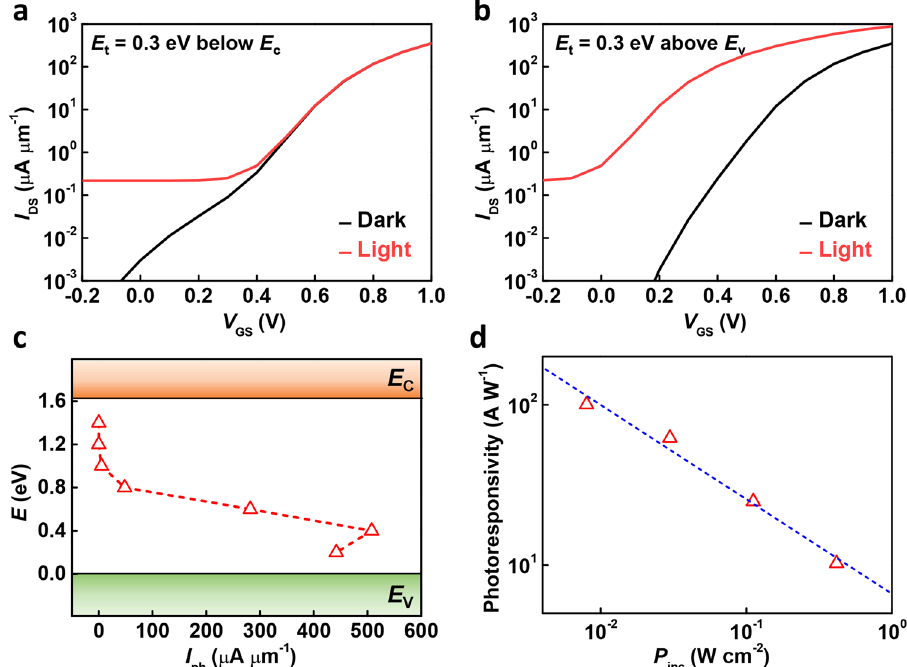
Fig. 5 Simulation of the photoresponsive behavior of the nanoporous MoS 2 phototransistor. Transfer characteristics of the nanoporous MoS 2 phototransistor assuming a single trap state (trap density of P t = 5 ´ 10 25 m (cid:2) 3 ) near a E C and b E V in the dark and under illumination ( λ ex = 405 nm, P = 417 mW cm − 2 ). c I inc ph variation with a single trap state at different Photoresponsivity as a function of P inc at λ ex = 405 nm with trap states at four different energy levels (the dashed line is a guide to the eye). E t = 0.3 and 0.4 eV above (below) E V ( E C ). The total trap density is the same as in Fig. 5a – c (i.e., 1 : 25 ´ 10 25 m (cid:2) 3